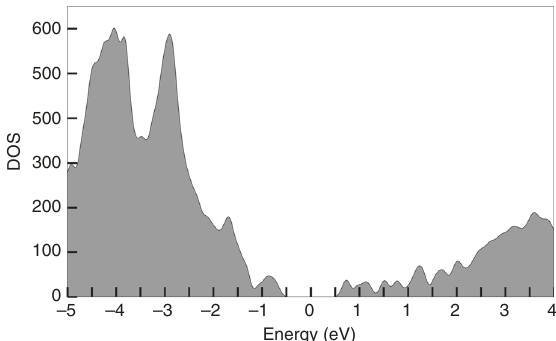
Fig. 7 DFT-computed electronic density of states (DOS) of the cluster polymer crystal. The cluster model 4 was used (as in Fig. 6) to build the periodic crystal, and the integration over the Brilloin zone was done in a 4 × 4 × 4 Monkhorst – Pack k-point mesh. The band gap is centered in the reciprocal space. The electronic density of states shown in Fig. 7 features broad valence ( E < 0) and conduction ( E > 0) bands with a fi ne structure. The apparent band gap, determined as the peak separation closest to the gap, is about 1.3 eV. This gap is comparable to the HOMO-LUMO and optical gap for the isolated cluster. The magnitude of the band gap indicates that the cluster polymer crystal should behave as a semiconductor-type material.